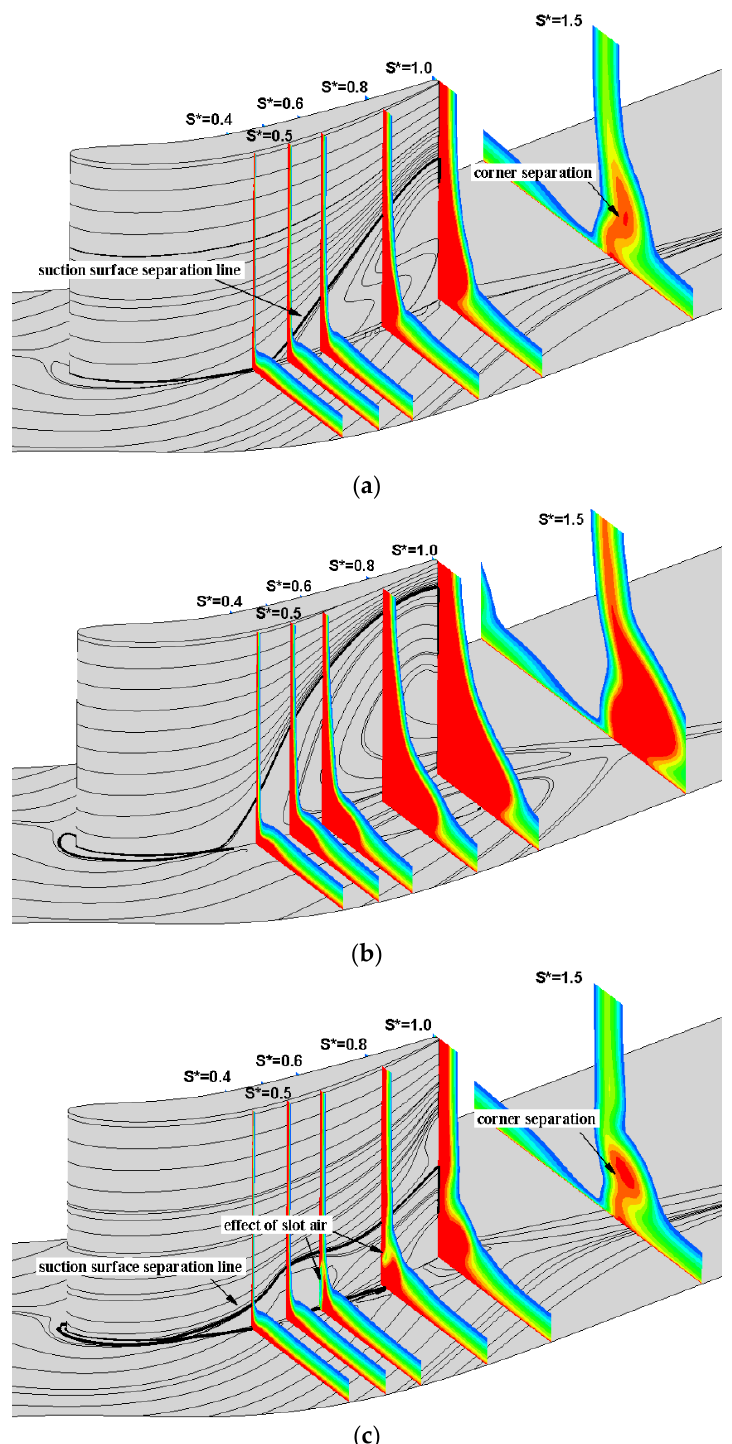
Figure 7. Influence of pitch-chord ratio on limiting streamlines and the passage total pressure loss coefficient at i = 0 ° incidence angle: ( a ) origin, s / c = 0.926; ( b ) origin, s / c = 1; and ( c ) slot, s / c = 1.